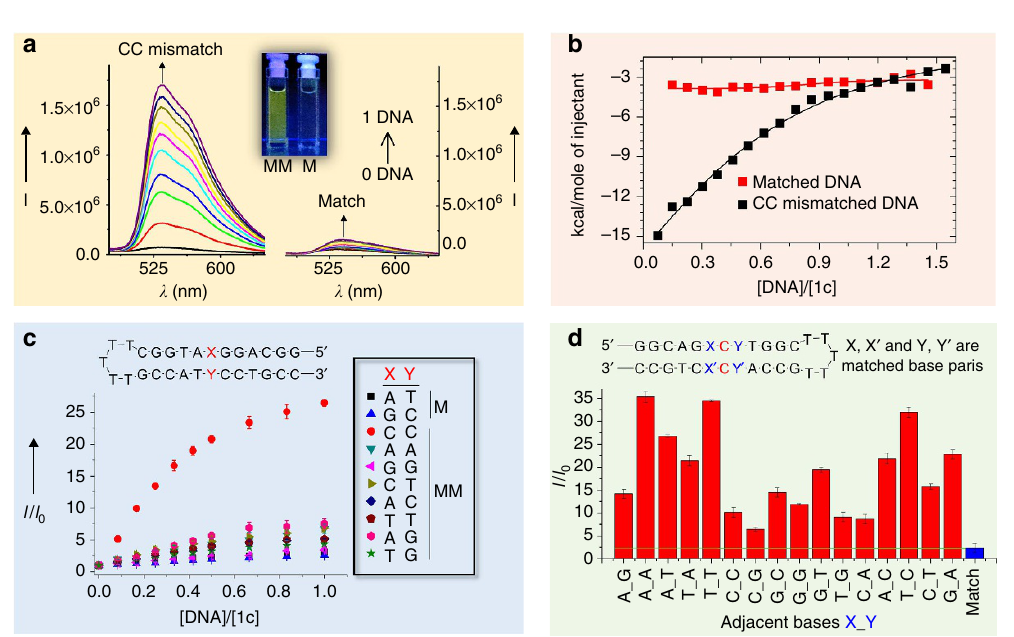
Figure 3 | Binding of 1c with mismatched DNA. ( a ) The emission spectra of complex 1c (5 m M) in a Tris buffer solution (50mM NaCl and 2mM Tris, pH 7.5) after binding to different concentrations of CC mismatched DNA (MM) and matched DNA (M). ( b ) Plot of integrated ITC data for the exothermic interaction between CC mismatched DNA (0.75mM) and 1c (0.1mM). ( c ) Changes in emission intensity ( ± s.e.m.) at 535nm of complex 1c (5 m M) in the Tris buffer solution upon the addition of different types of DNA. M, match; MM, mismatch. ( d ) Relative emission enhancement of 1c towards CC MM DNA with different adjacent base pairs.